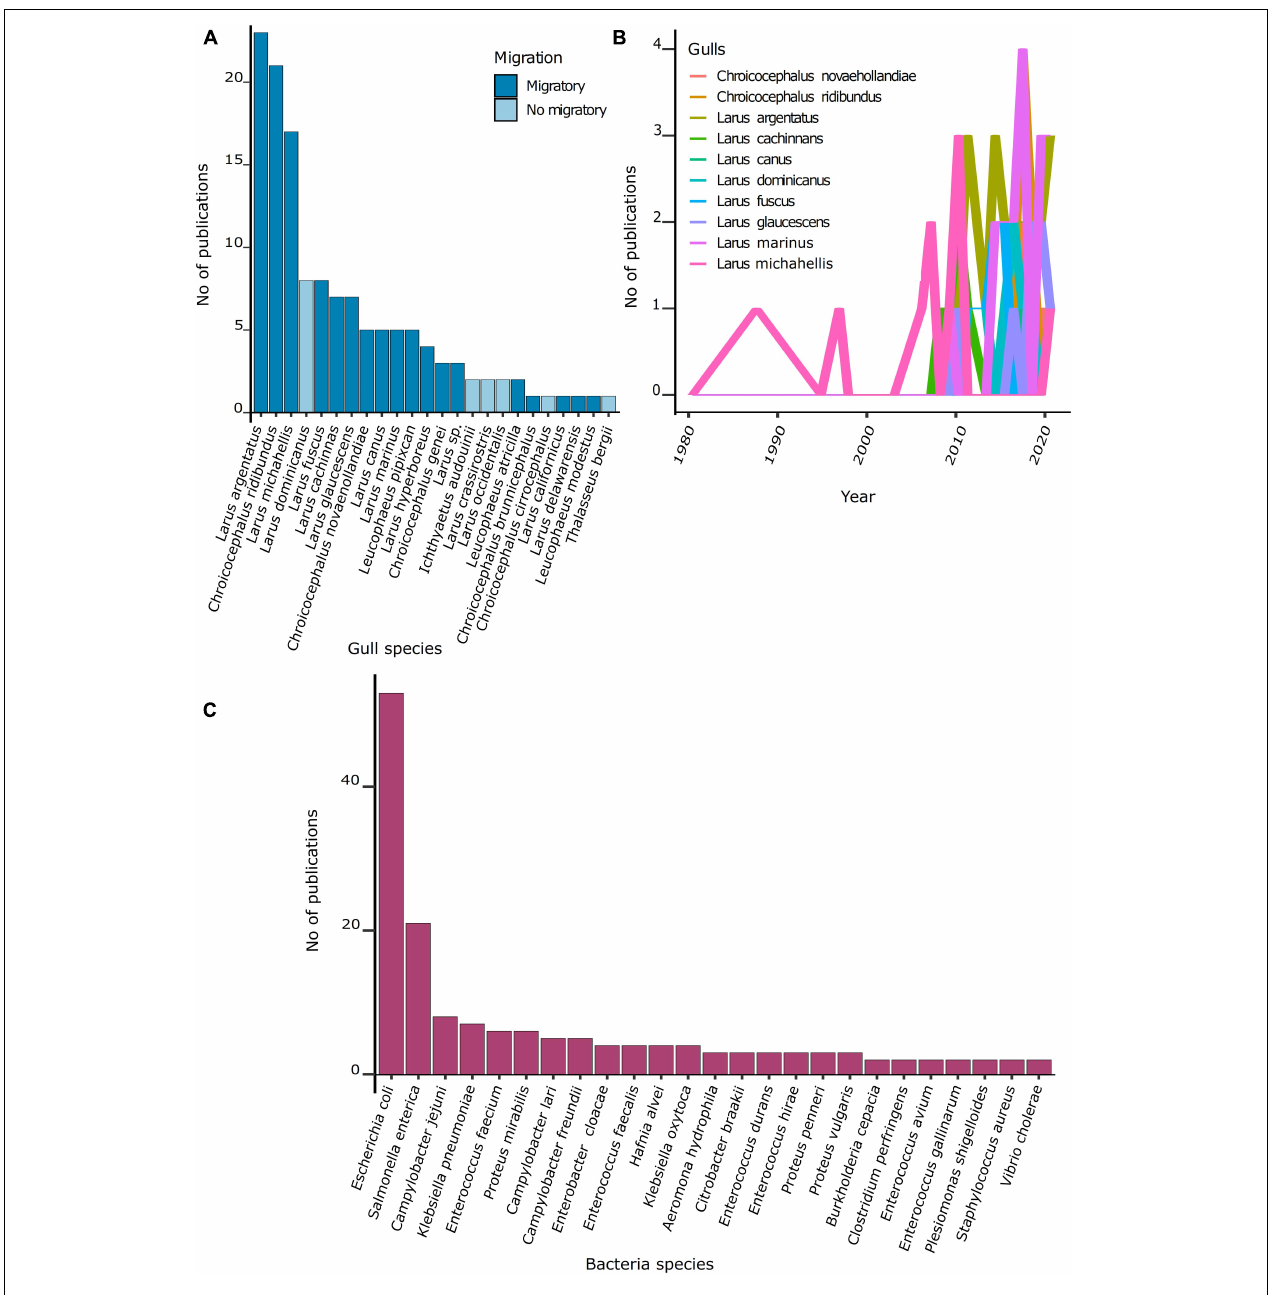
FIGURE 3 | Number of publications per gull and bacteria species. (A) Number of publications per gull species. (B) Number of publications per gull species over the 1980–2020 period. (C) Number of publications per bacteria